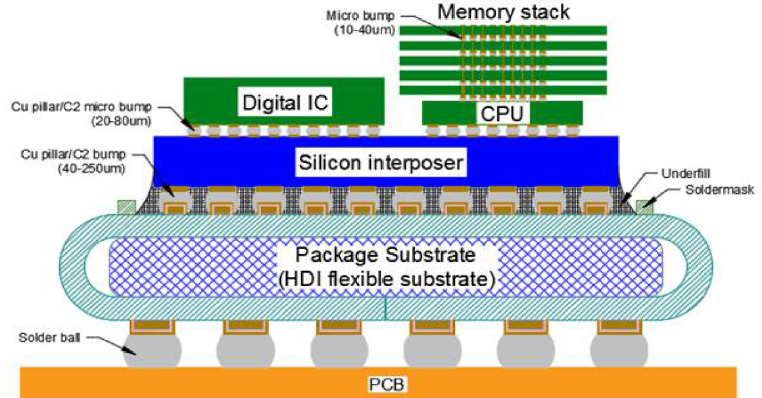
Figure 2. Heterogeneous integration in an advanced electronic package (Pun, Islam, Rotanson, Cheung & Chan,